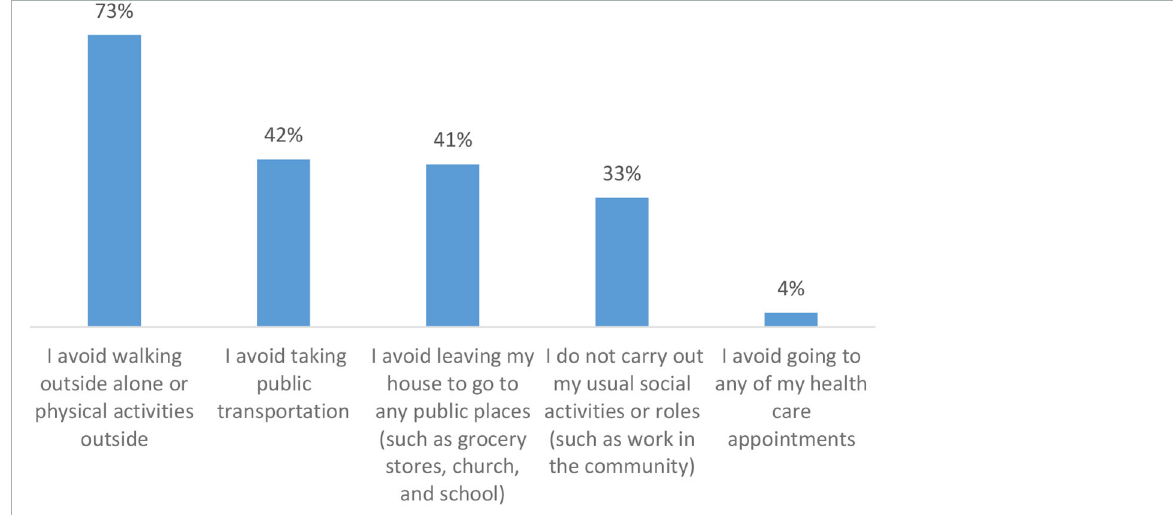
TABLE 2 Changes to routine activities due to racism related to COVID-19.